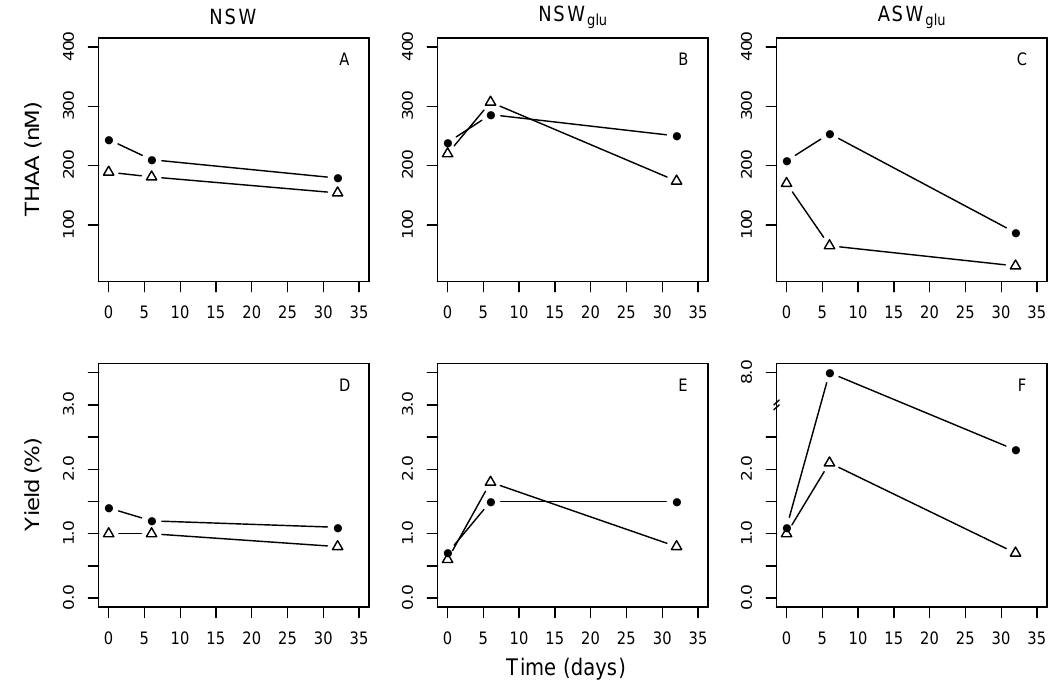
Figure 4. Concentration and yield of total hydrolyzable amino acids (THAA). • represents Atlantic treatments and 1 represents Arctic treatments. Note the different scales of the axes and the broken axis on the yield plot of the artificial